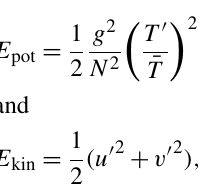
Table 2. Number of nights and 1h profiles taken into account for figures showing monthly mean